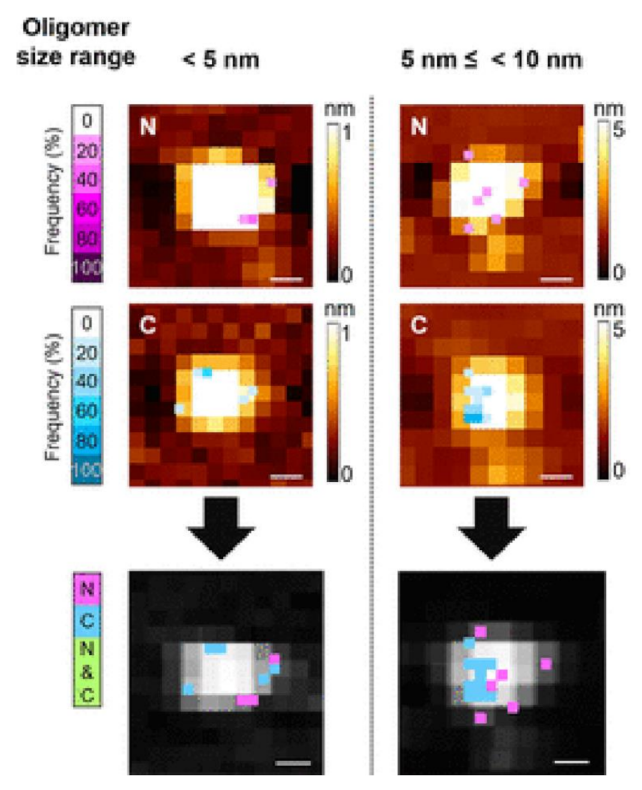
Figure 1. The surface structure of a PFO. Yoon et al., studied, at molecular resolution, the structure of individual A β PFOs by means of an innovative AFM technique, which involves the use of tips linked to the specific terminal antibody. Flexible zones, consisting of N- and C-terminals exposed to the solvent, emerge from a rigid and hydrophobic core. Bar represents 10 nm (Reprinted with permission from Yoon et al. [52]. Copyright 2019 American Chemical